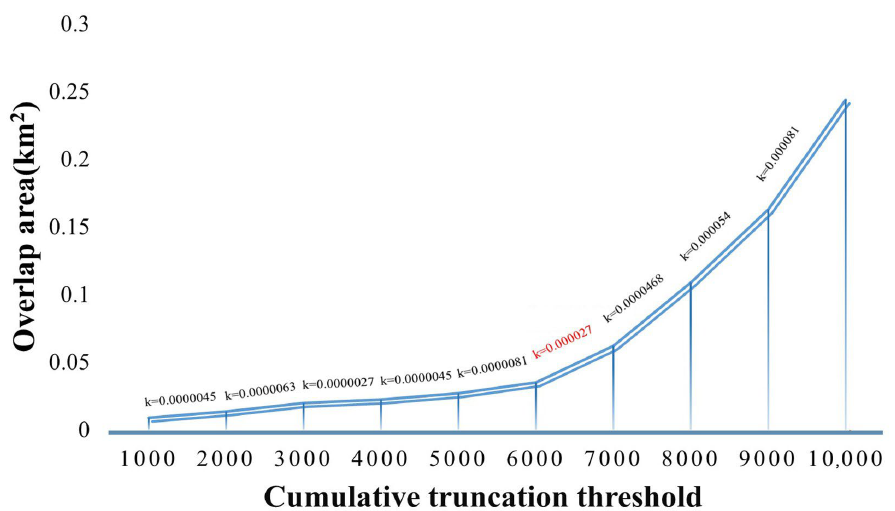
Figure 9. Area of overlap between different corridor areas and construction land.